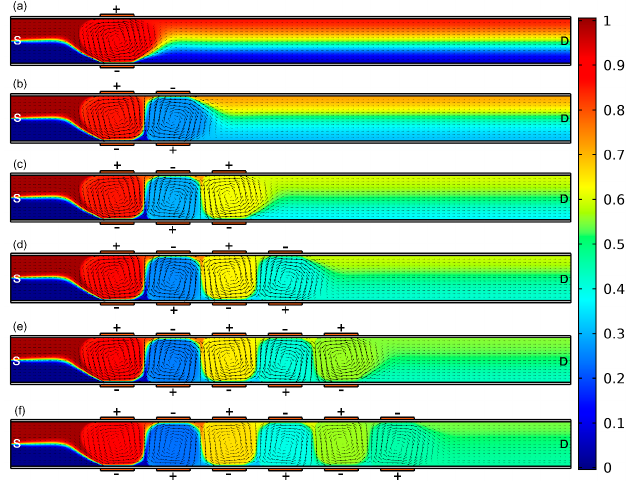
Figure 6. Simultaneous pumping and mixing of microflows in the device configuration with different sets of inverted B-DCFFET. ( a – e ) For given values of Vs = 70 V, V G1 = − V G2 = 900 V, L G = 150 μm and L GG = 100 μm, an arrow and surface plot of the DCEO flow field and resulting sample concentration distribution (mol/m 3 ) in the integrated device design of a distinct number of G terminals; (a) single-inverted B- DCFFET of γ = 49.83%, (b) double-inverted B- DCFFET of γ = 74.38%, (c) triple-inverted B-D CFFET of γ = 85.71%, (d) quadruple-inverted B- DCFFET of γ = 88.87%, (e) quintuple-inverted B- DCFFET of γ = 92.45% and ( f ) sextuple-inverted B- DCFFET of γ = 94.79%. It is noteworthy that the highly-integrated electroosmotic pump and mixer embedded with twelve gate terminals of alternating voltage polarities exhibits optimum performance for fully-automated electrokinetics-driven analyte treatment (f), which makes it possible for us to receive almost perfect liquid mixture in the channel outlet port.